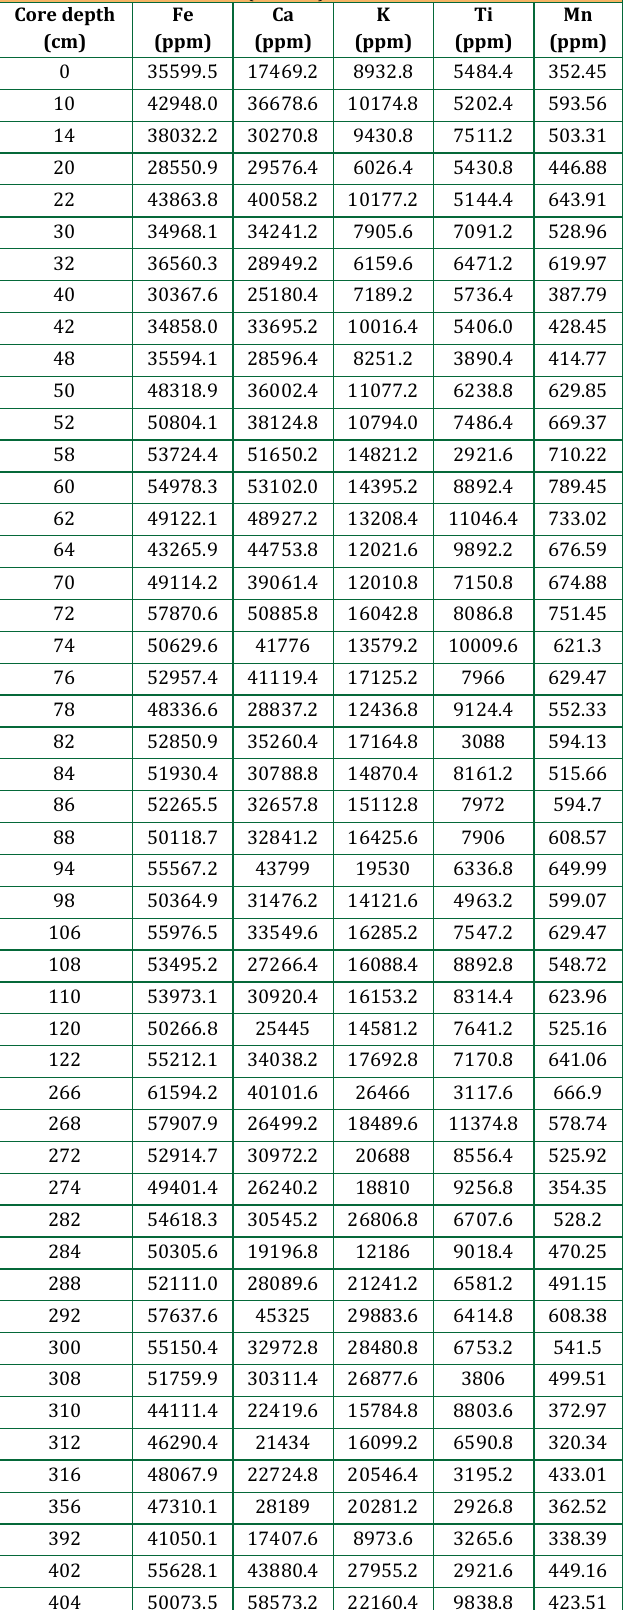
Table 2 : Down core significant variations of major elements concentrations (± 8.6 %) in the core